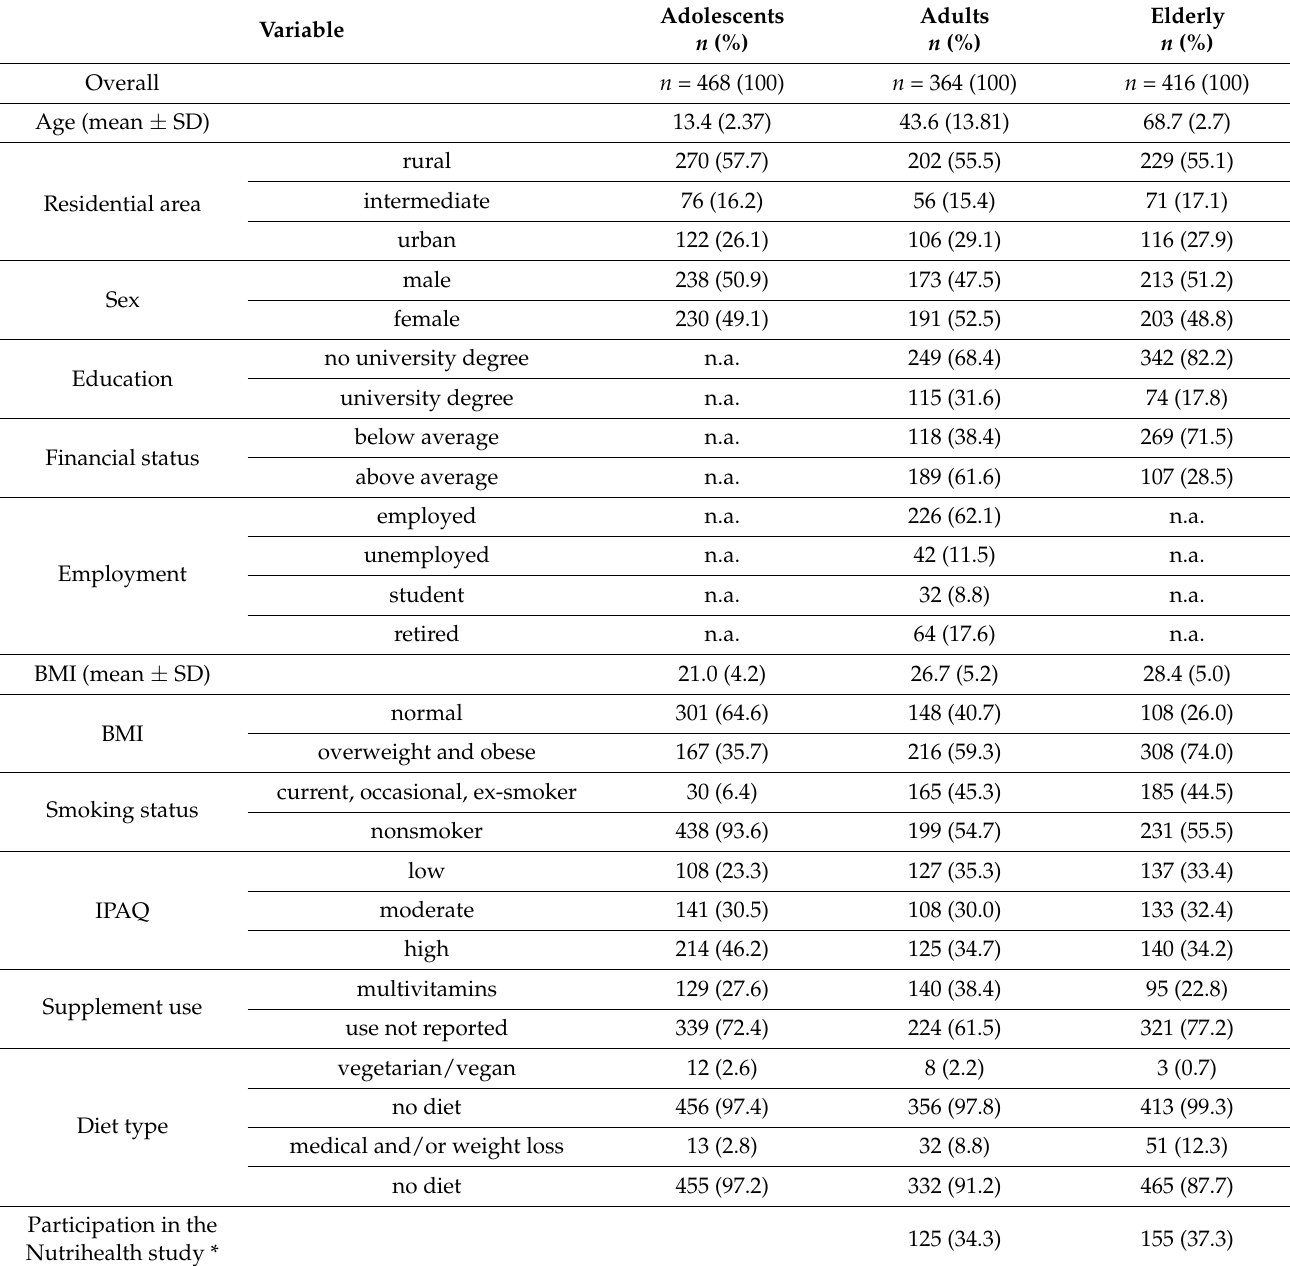
Table 1. Demographic characteristics of the SI.Menu study sample for all three age cohorts (adoles- cents: 10–17 years; adults: 18–64 years; elderly: 65–74